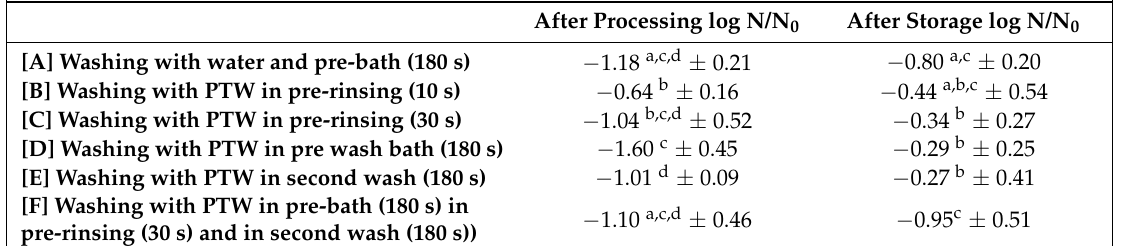
Table 3. Reduction of total viable count on endive lettuce after washing process with or without addition of plasma-treated water at different processing steps and subsequent storage at 2 ◦ C for seven days. Letters in square brackets refer to the six trials described in Section